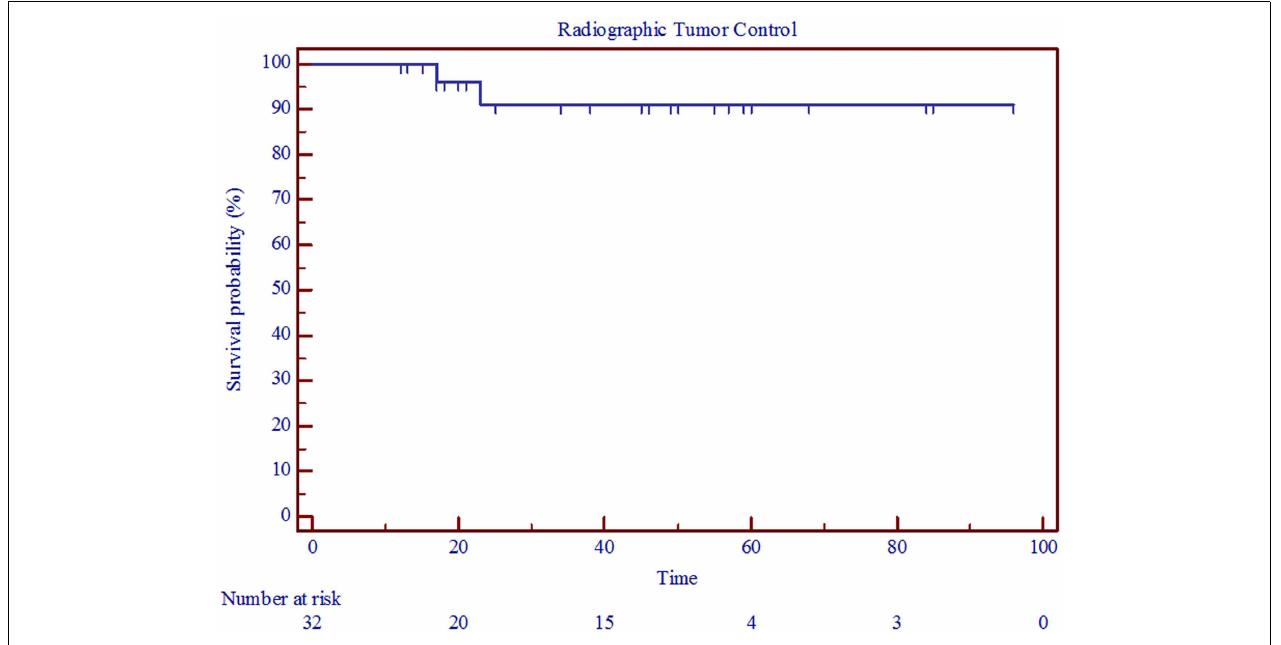
FIGURE 1 | Kaplan–Meier curve showing radiographic tumor control in 32 patients treated with radiosurgery for vestibular schwannoma between 2002 and 2011.